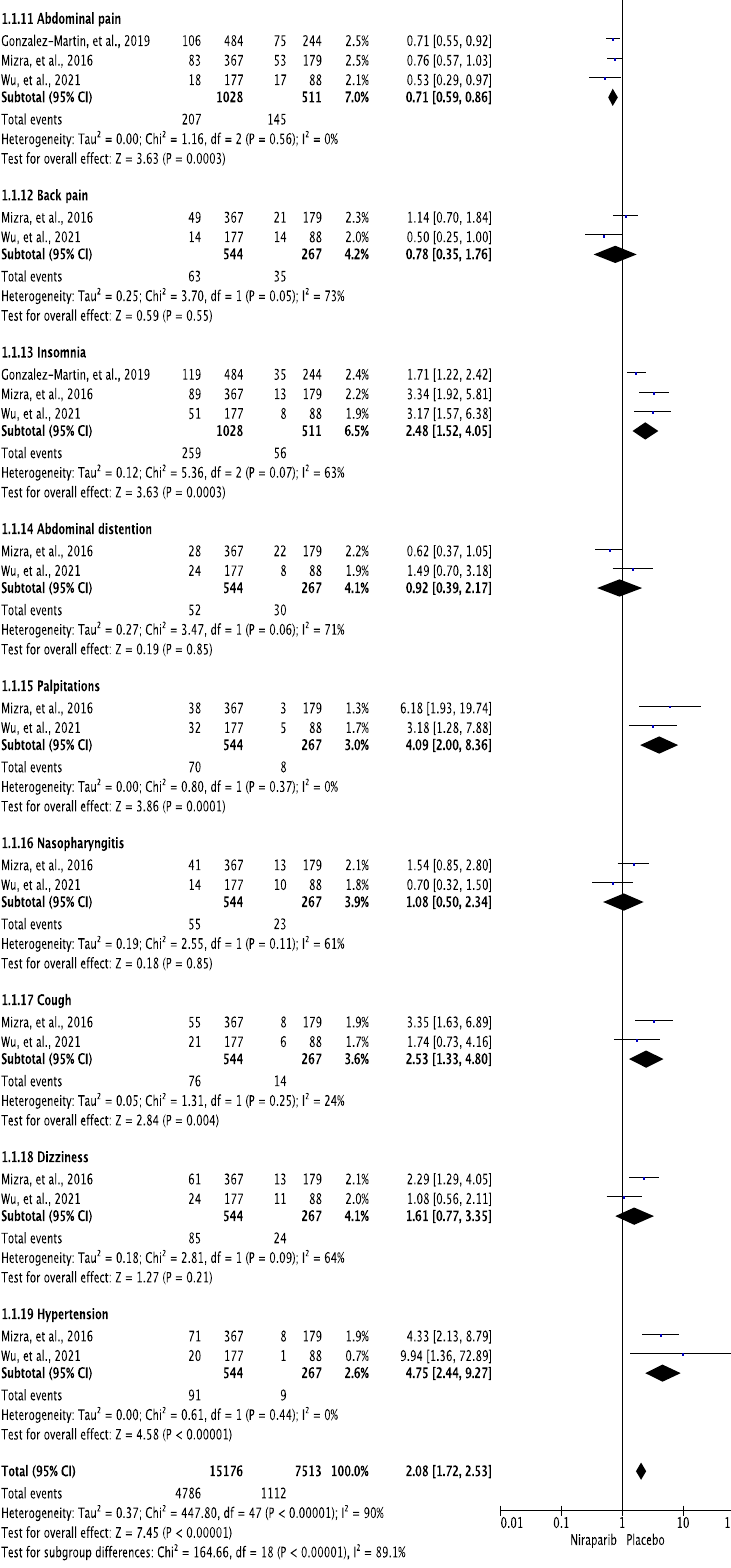
Figure 2. Forest plot of the meta-analysis of any grade adverse effects in NOVA, PRIMA and NORA studies.